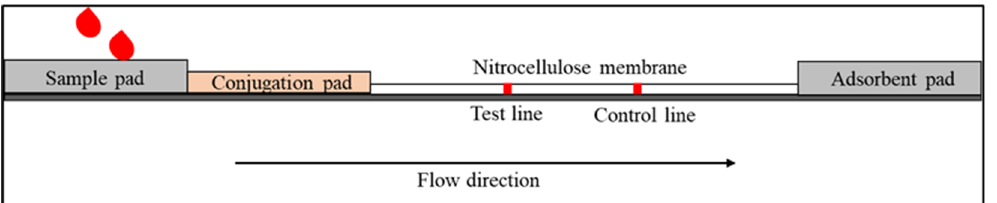
Figure 1. Schematic diagram shows the basic structure of LFI that consists of a sample pad, conju- gation pad, nitrocellulose membrane and adsorbent pad. tion pad, nitrocellulose membrane and adsorbent